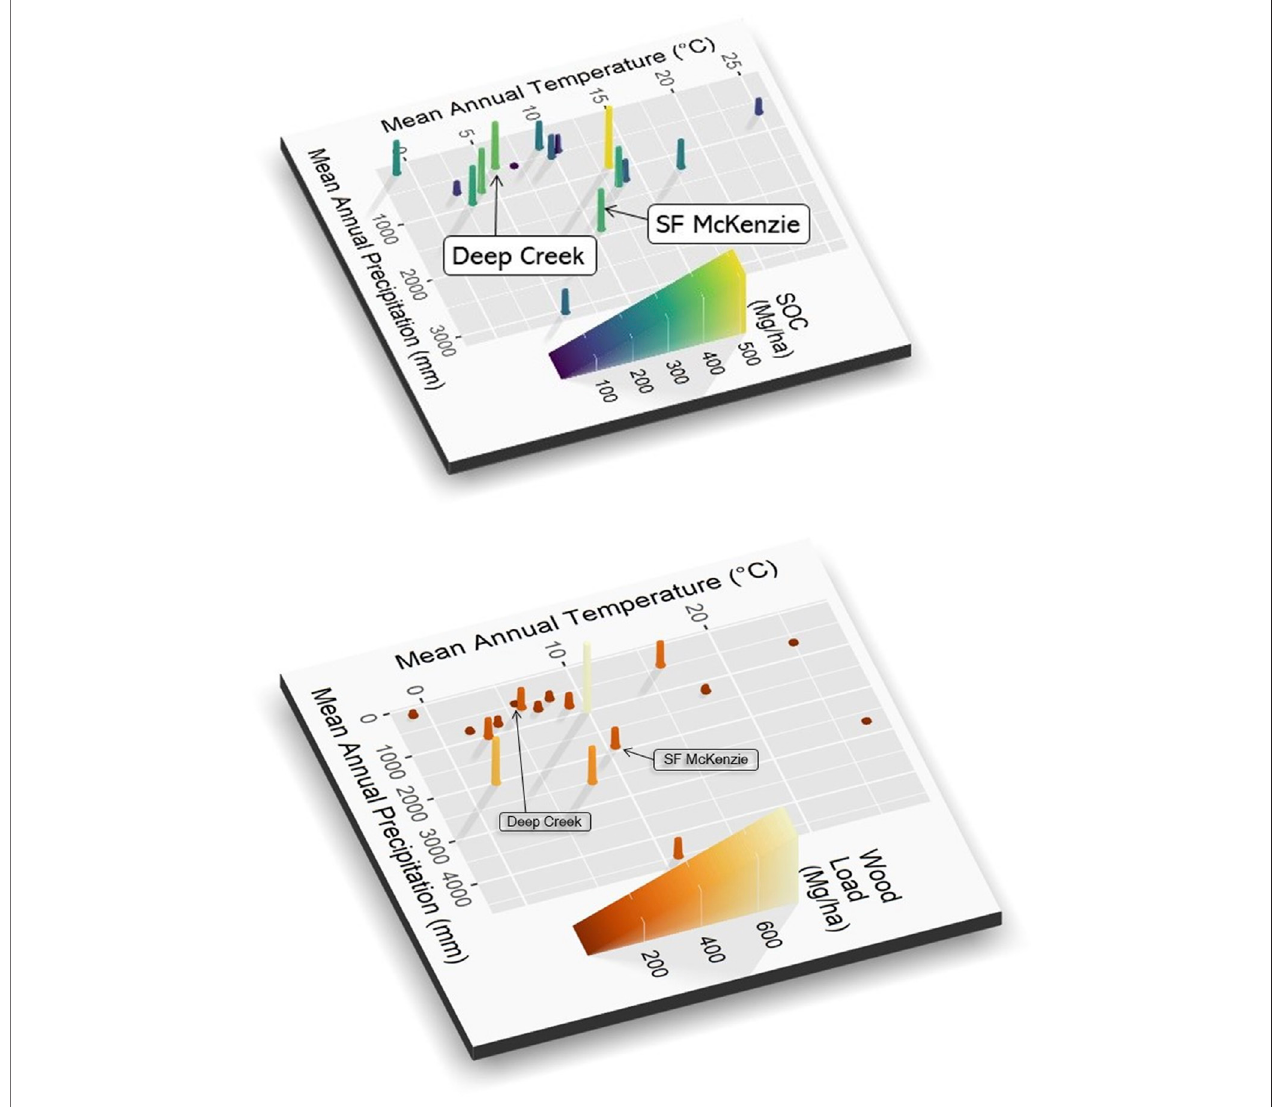
FIGURE 3 | Magnitude of organic carbon stock in fl oodplain soil (top) and fl oodplain wood load (bottom). These distributions are based on limited data and thus likely to change as more fi eld sites are characterized. Labels indicate the location of the reference-site values for the case studies in this paper. Data used to generate these plots are in supplementary